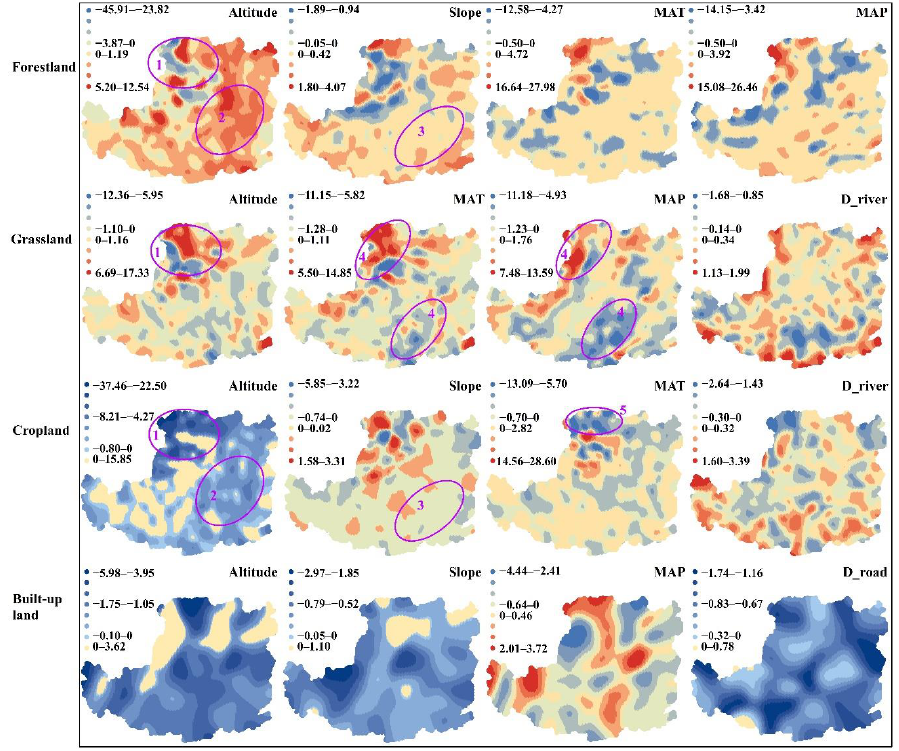
Figure 6. Estimation of Geographically Weighted Logistic Regression coefficients for the four dominant factors. dominant